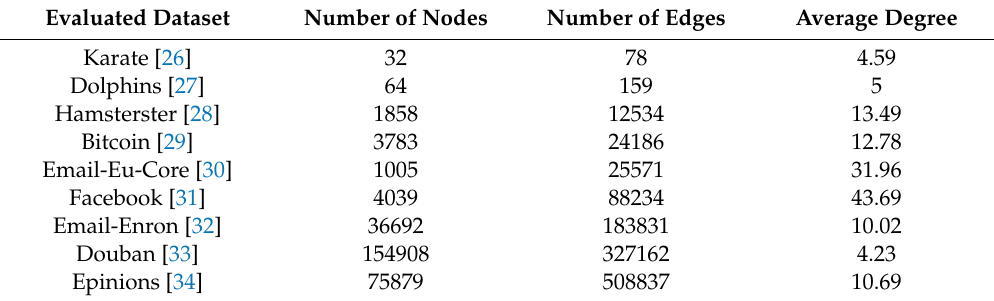
Table 2. Evaluated